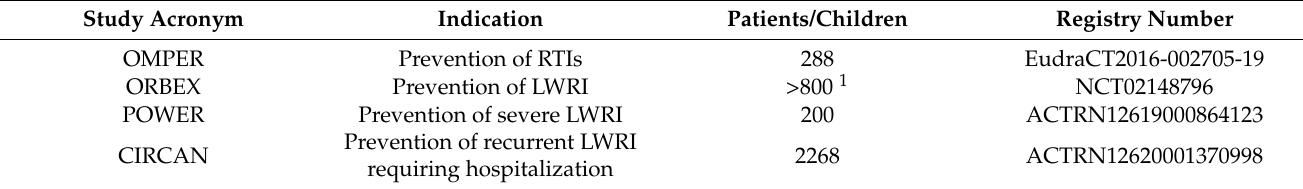
Table 1. Studies with OM-85 bacterial lysates investigating mechanistic endpoint including the effect on children microbiota. Study